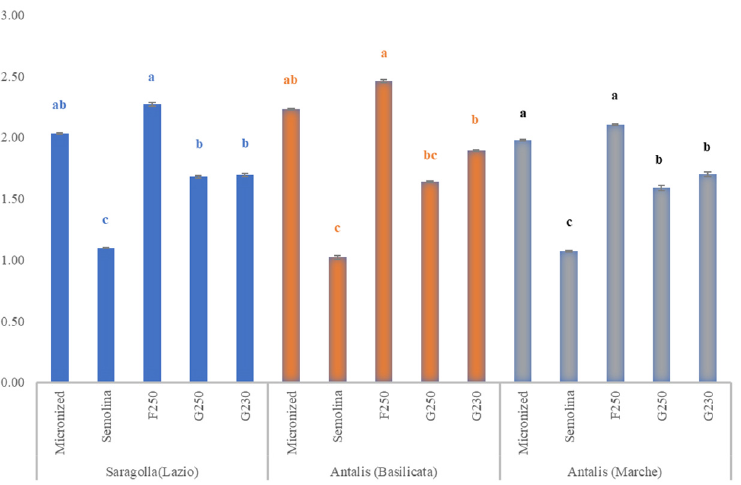
Figure 4. Mean values of ash content (d.m.%) of five milling products: micronized sample, semolina, F250, G250 and G230 air-classified fractions obtained from Saragolla_LA, Antalis_BA and Antalis_MA. Different letters indicate statistically significant differences ( p < 0.05, n = 3) within each cultivar sample.